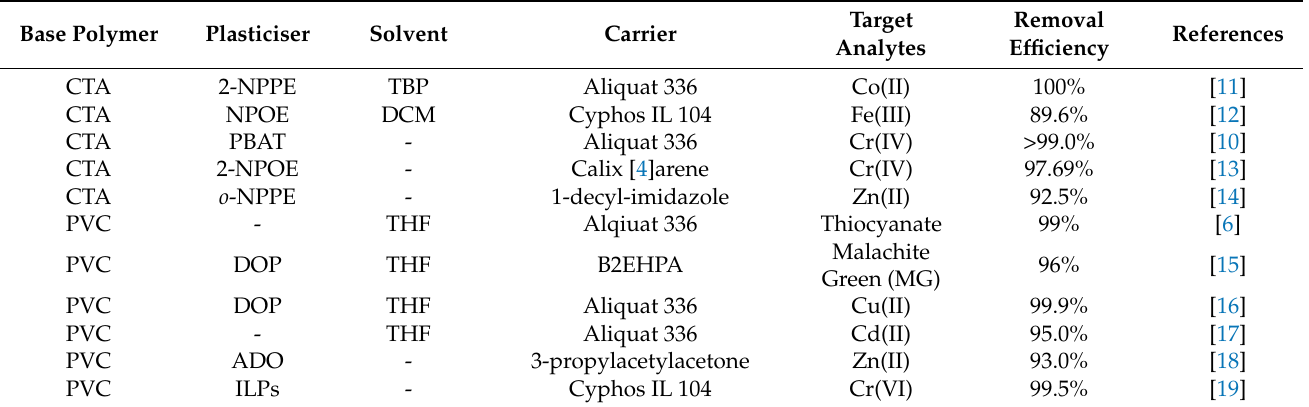
Table 1. Examples of different formulations of PIMs and their